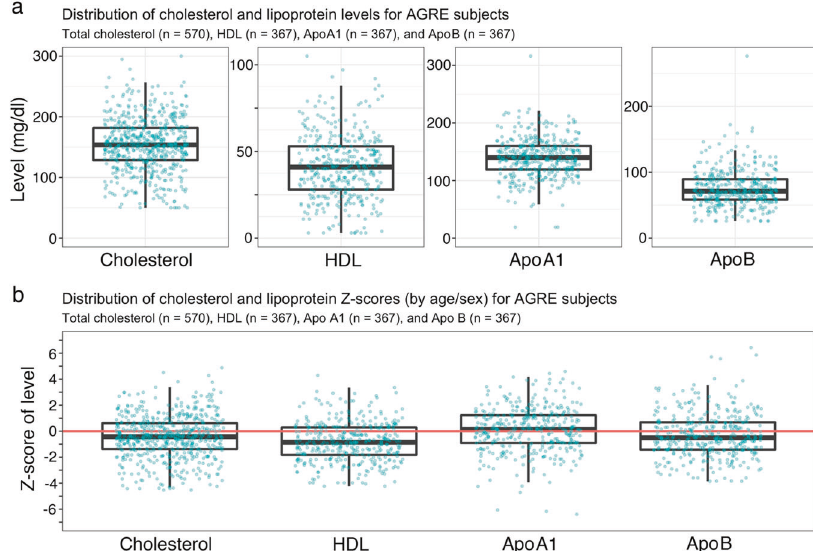
Fig. 2 Distribution and Z -scores of cholesterol and lipoprotein levels in AGRE subjects. a Distributions of cholesterol (CHL) ( n = 570), HDL, apolipoprotein A1 (ApoA1), and ApoB (each n = 367). Points represent levels (in mg/dL) for individual AGRE subjects. For the boxplots: centerline is median value, edges of box are upper and lower quartiles, whiskers extend to 1.5 times the interquartile range from the edge of the box. Points above and below the whiskers represent outliers. b Distributions of Z -scores for CHL ( n = 570), HDL, ApoA1, and ApoB (each n = 367). Z -scores were calculated as Z = (level − mean)/(standard deviation), using age- and sex-speci fi c means and standard deviations estimated using subjects from the National Health and Nutrition Examination Survey III (NHANES-III). Points represent Z -scores for individual AGRE subjects. For the boxplots: centerline is median value, edges of box are upper and lower quartiles, whiskers extend to 1.5 times the interquartile range from the edge of the box. Points above and below the whiskers represent outliers. Two outlying Z -scores are not shown on this plot: Z = 11.4 for ApoA1 and Z = 14.4 for